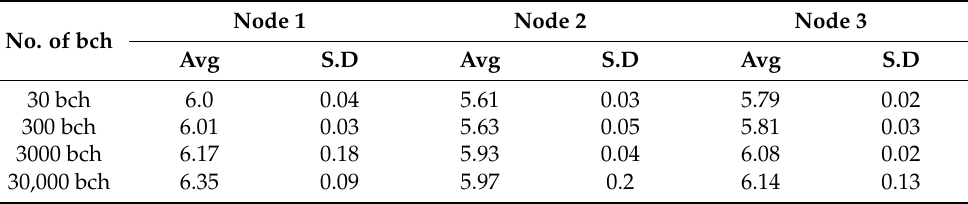
Table 6. CPU time (h) of a cluster consisting of three processors. In order to exclude the effect due to the difference in node performance, one processor was mobilized from each node. The results obtained by repeating the same simulation five times, as in the individual node evaluation, were averaged. Avg means the average value at this time, and SD means the standard deviation of the measured